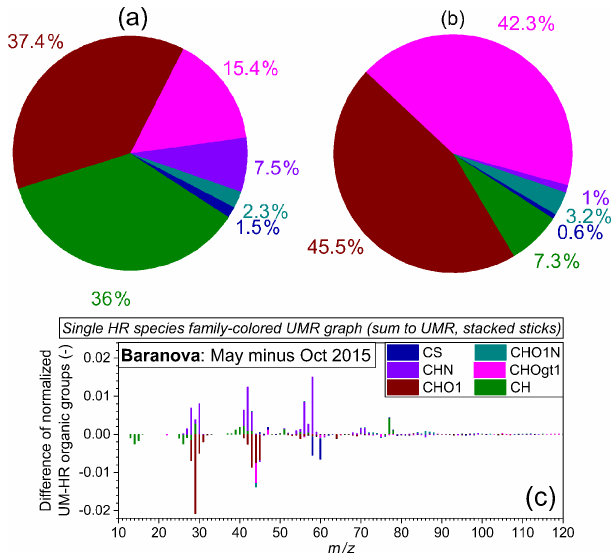
Figure 7. Offline AMS-based fractional contribution of the different organic aerosol families for (a) Cape Baranova (H : C = 1.53, O : C = 0.53) and (b) Alert (H : C = 0.81, O : C = 1.64) during October 2015. (c) Single organic species family-colored (stacked sticks) dif- ference of the May minus October 2015 normalized mass spectrum. The former sample is expected to be influenced by pollution trans- port from mainland Russia. Data were taken and analyzed at high resolution but are summed to unit mass resolution for